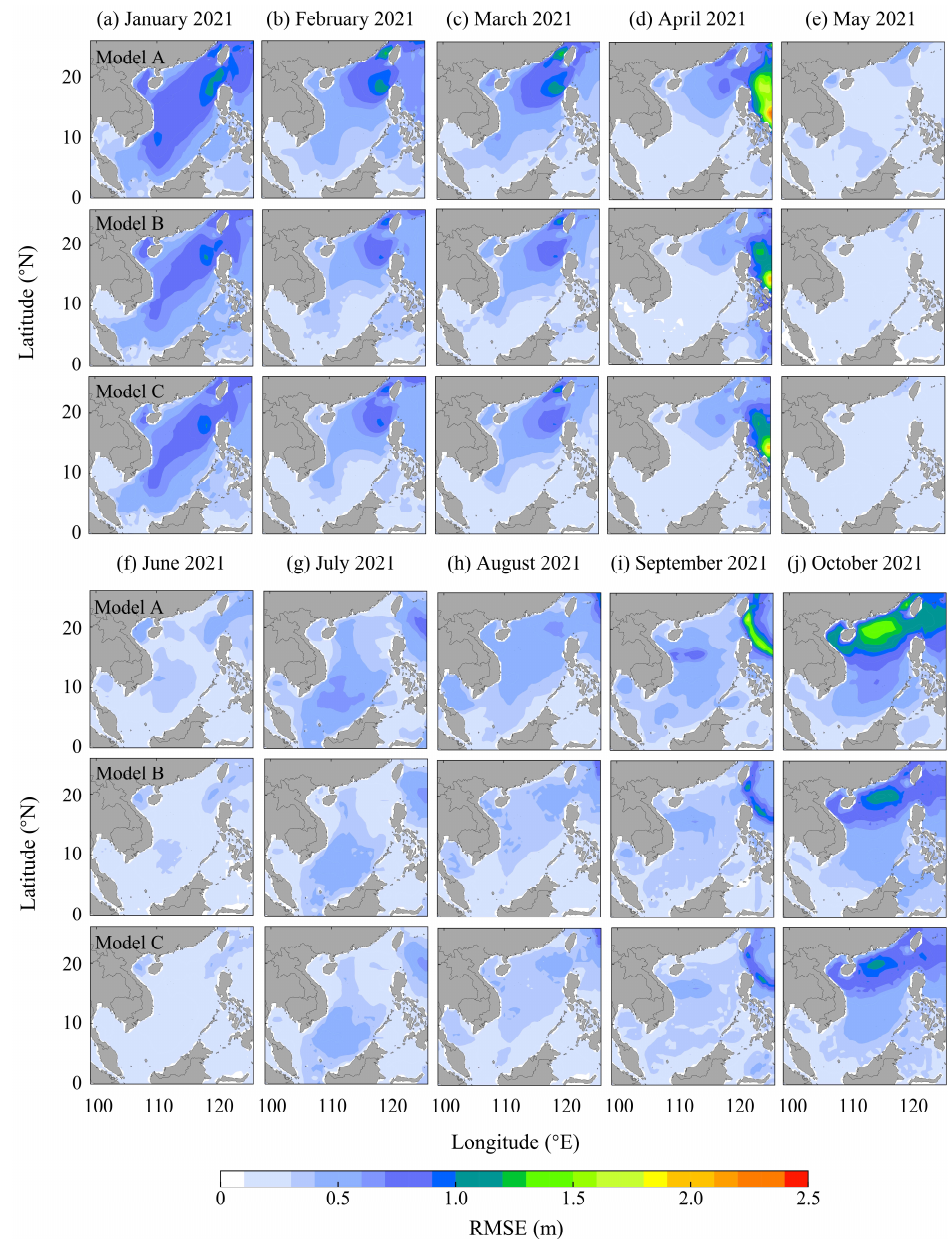
Figure 6. Spatial distribution of monthly mean RMSE of Model A, B, and C in the 24-h SWH forecasting results. (a)-(j) January to October 2021, respectively.